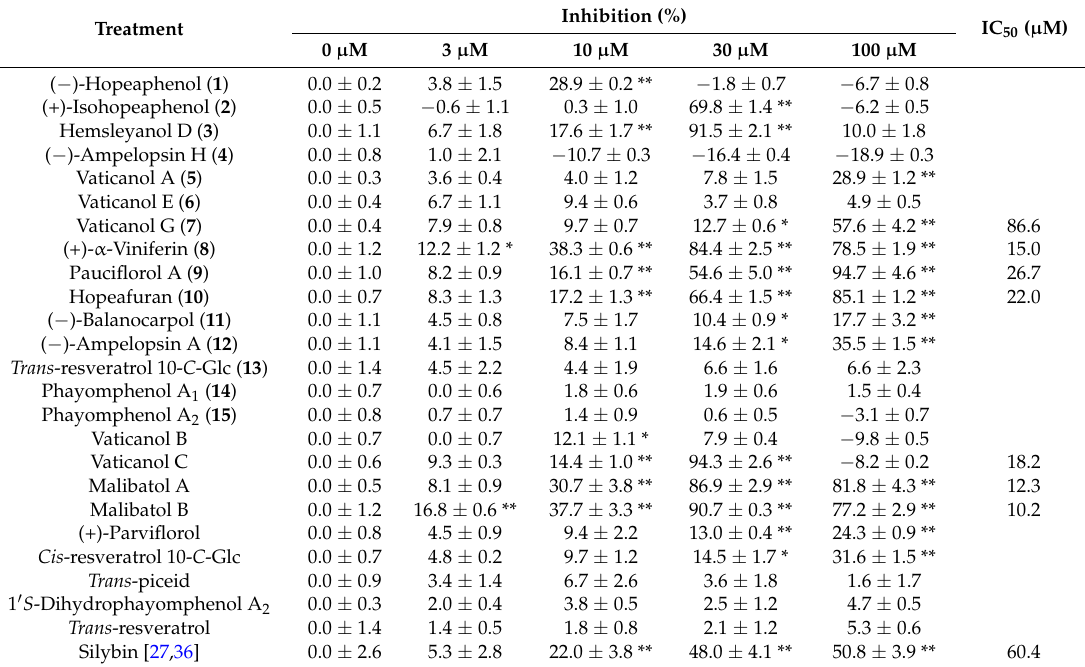
Table 8. Inhibitory effects of the constituents from bark of Shorea roxburghiii on TNF- α -induced cytotoxicity in L929